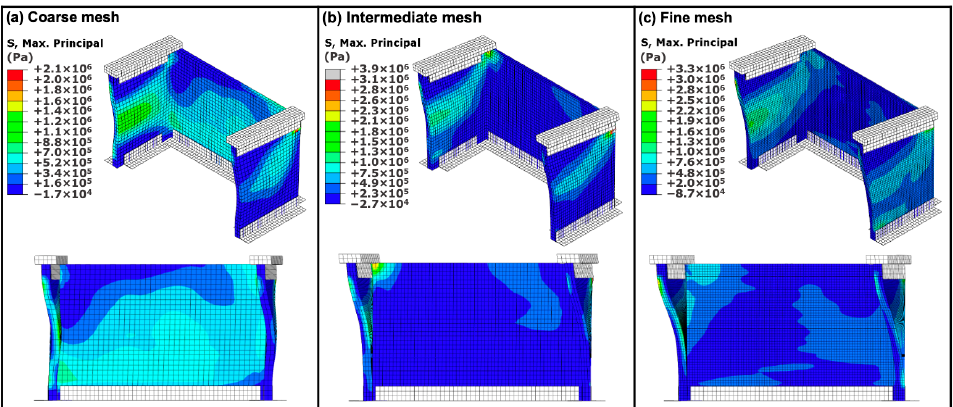
Figure 6. ( a ) Finite-element (FE) mesh of 3D model of U-shaped wall subjected to shaking table testing; ( b ) U-shaped wall with flat corners; and ( c ) U-shaped wall with round corners.